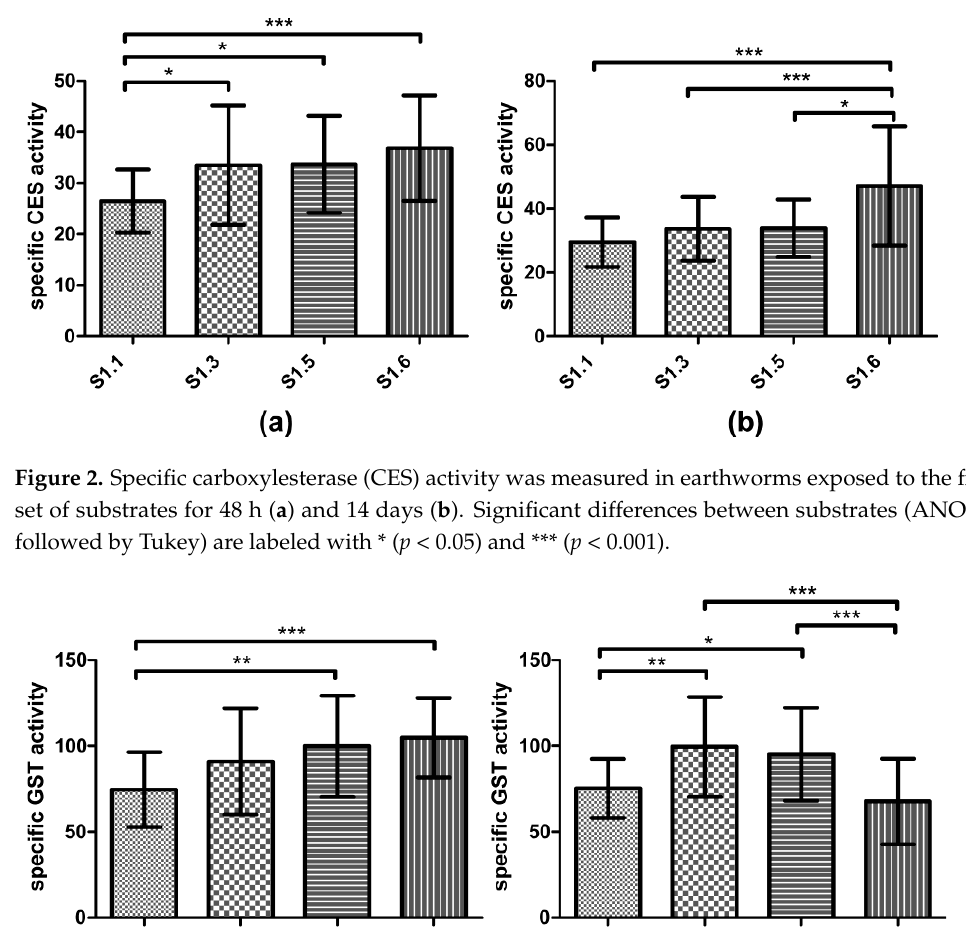
Figure 1. Specific acetylcholinesterase (AChE) activity was measured in earthworms exposed to the first set of substrates for 48 h ( a ) and 14 days ( b ). Significant differences between substrates (ANOVA followed by Tukey) are labeled with * ( p < 0.05) and *** ( p < 0.001).